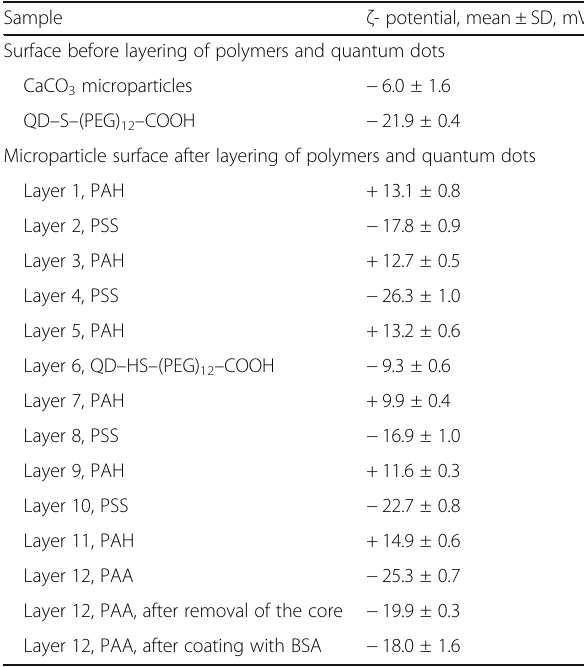
Table 1 Surface charge of the microparticles upon of polymer layer deposition and encoding with quantum dots. Number of each repeated measurements n = 5 Sample ζ - potential, mean ± SD, mV Surface before layering of polymers and quantum dots CaCO 3 microparticles − 6.0 ±